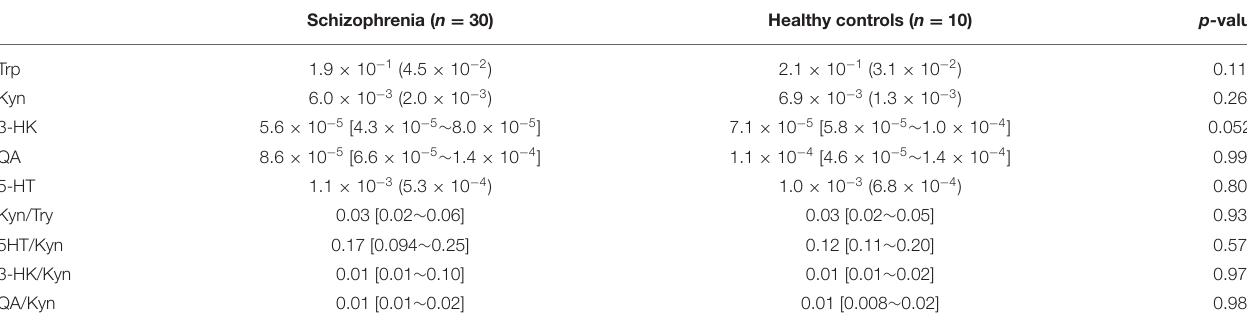
TABLE 2 | Serum levels of the metabolites of the Kyn pathway in the schizophrenia and healthy control groups. Schizophrenia ( n = 30)